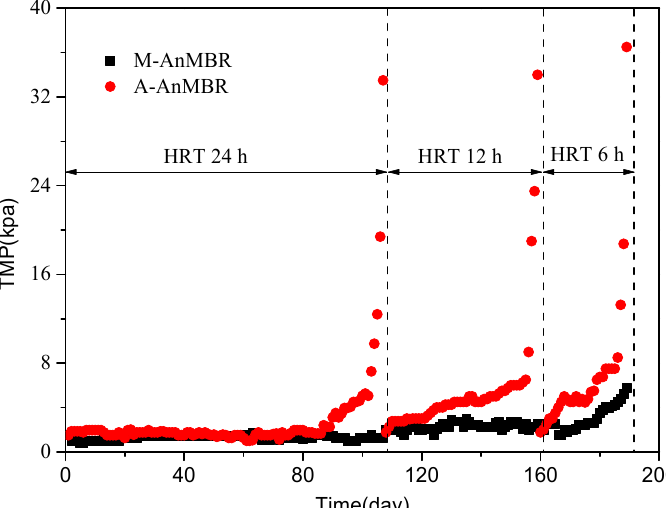
Figure 2. The transmembrane pressure (TMP) profiles plotted as a function of time in the M-AnMBR and A-AnMBR.